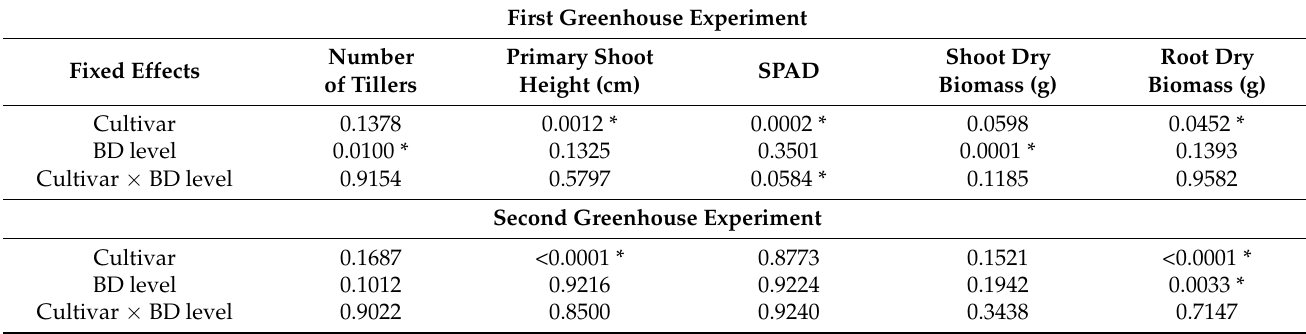
Table 1. ANOVA p -values for number of tillers and primary shoot height at 96 DAP, SPAD, shoot dry biomass, and root dry biomass in response to sugarcane cultivar and bud germination level.